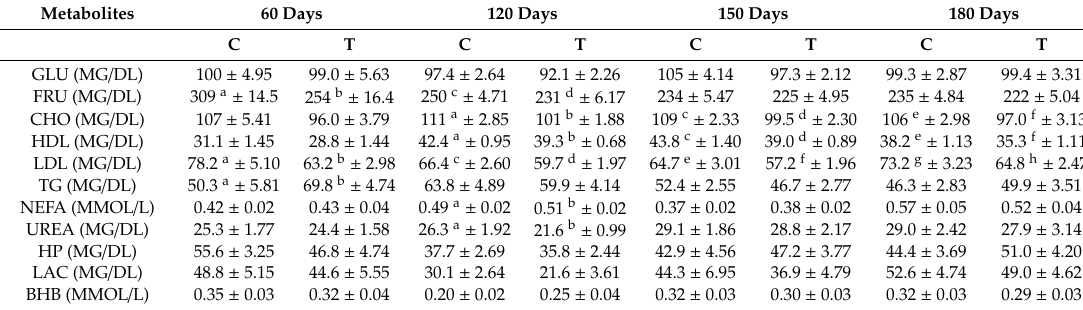
Table 3. Changes over time in mean plasma concentrations ( ± S.E.M.) for main metabolic parameters in pigs born from sows treated or not with hydroxytyrosol and linseed oil during pregnancy (groups T, n = 20, and C, n = 17,